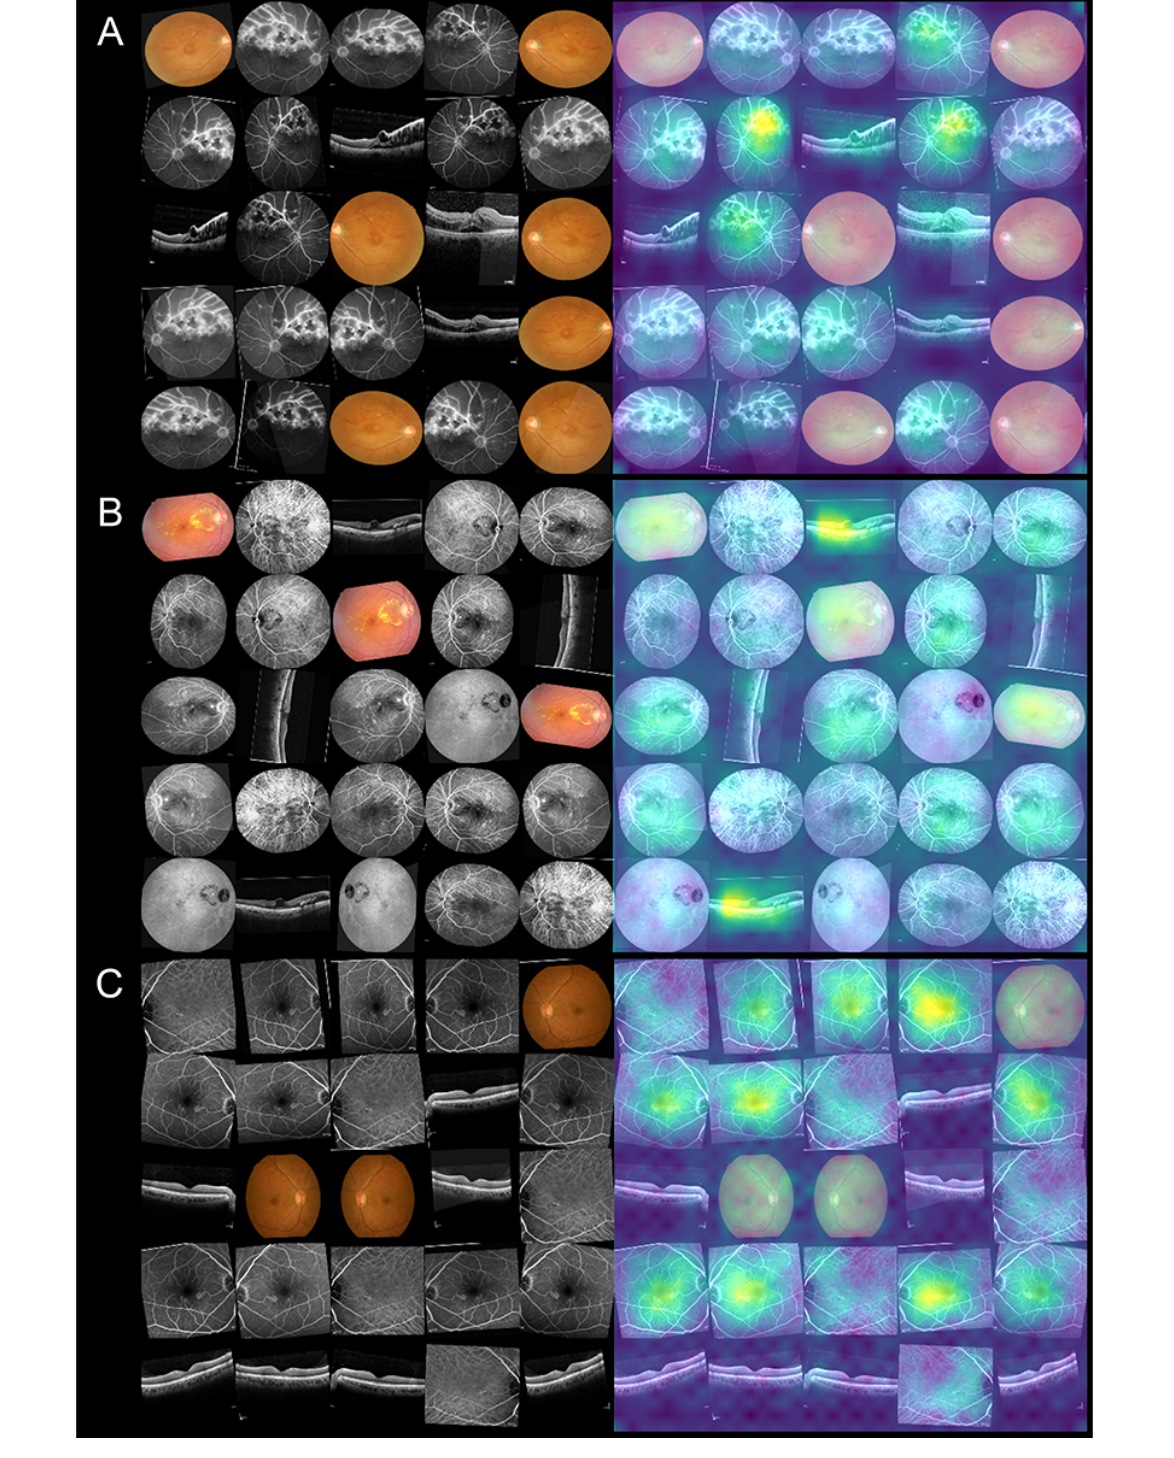
Figure 5. Sample heat maps generated by the prediction model in a true-positive patient with (A) treatment-requiring branch retinal vein occlusion, (B) treatment-requiring diabetic macular edema, and (C) non–treatment-requiring age-related macular